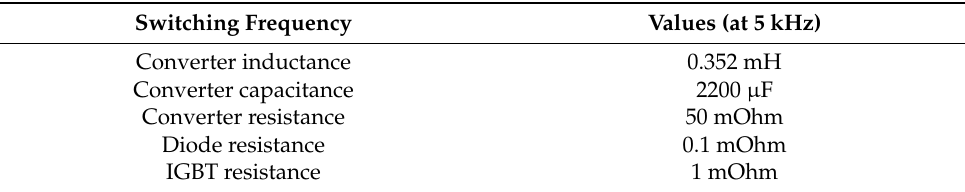
Figure 16. DC–DC solar converter system of MPPT using the P and O method. Table 7. Parameters of solar PMS.